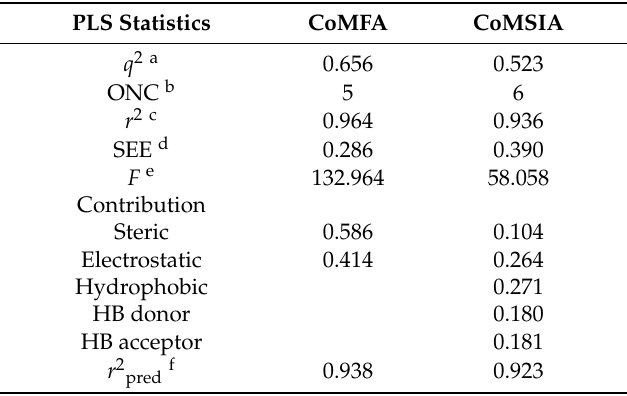
Table 1. Statistical results of the CoMFA and CoMSIA